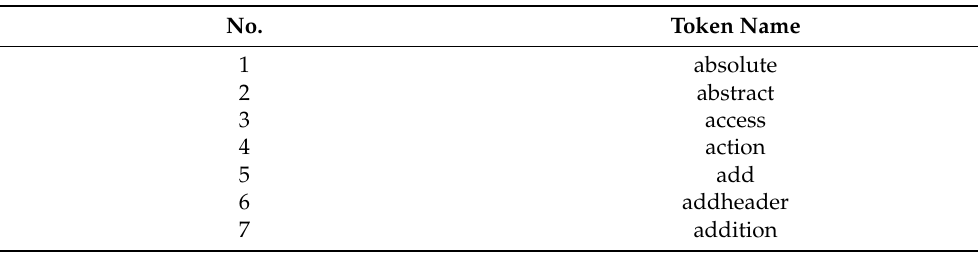
Table 1. A sample of C/C++ and Java Tokens identified in NIST datasets, ordered alphabetically (part of the control flow